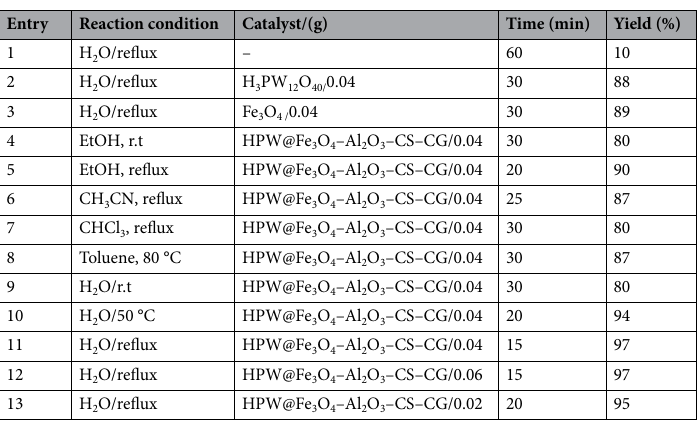
Table 1. The results of 6-Amino-7-cyano-8-phenyl-8H-[1,3]dioxolo [4,5-g]-chromene synthesis under heating conditions. Reaction conditions: HPW@Fe 3 O 4 –Al 2 O 3 –CS–CG, Solvent (5 ml).